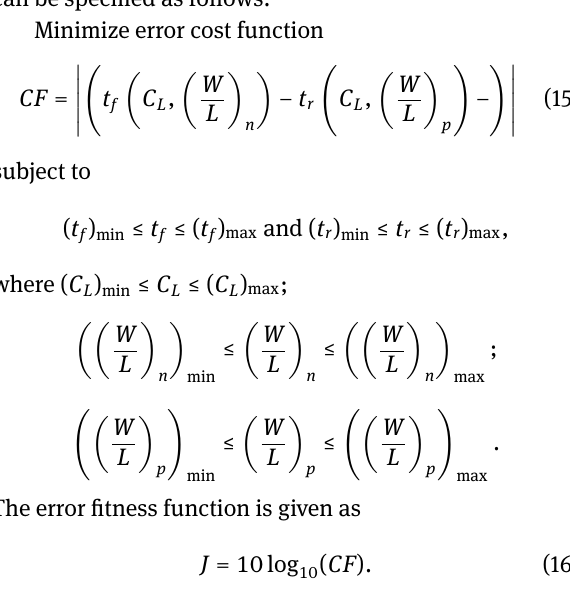
Table 2: Delay limits and design parameters bound for the Case study-1. Design Set